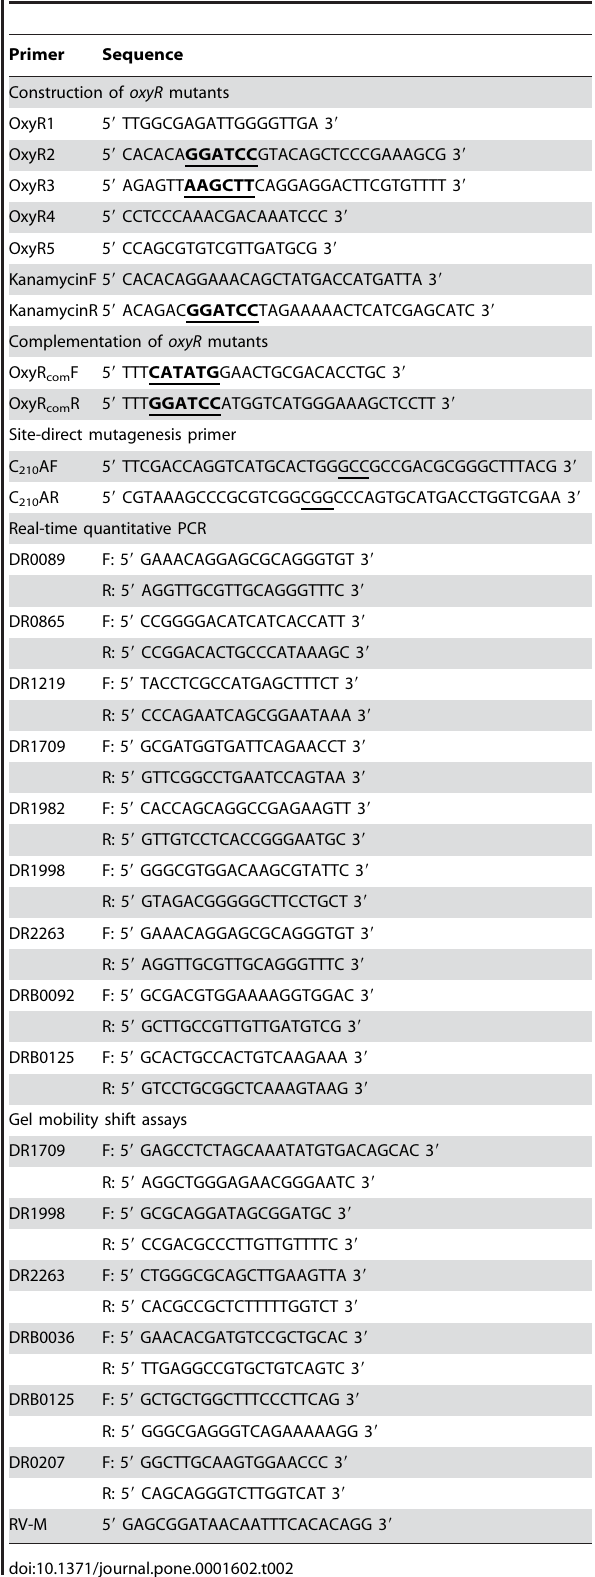
Table 1. Bacterial strains and plasmids used in this study